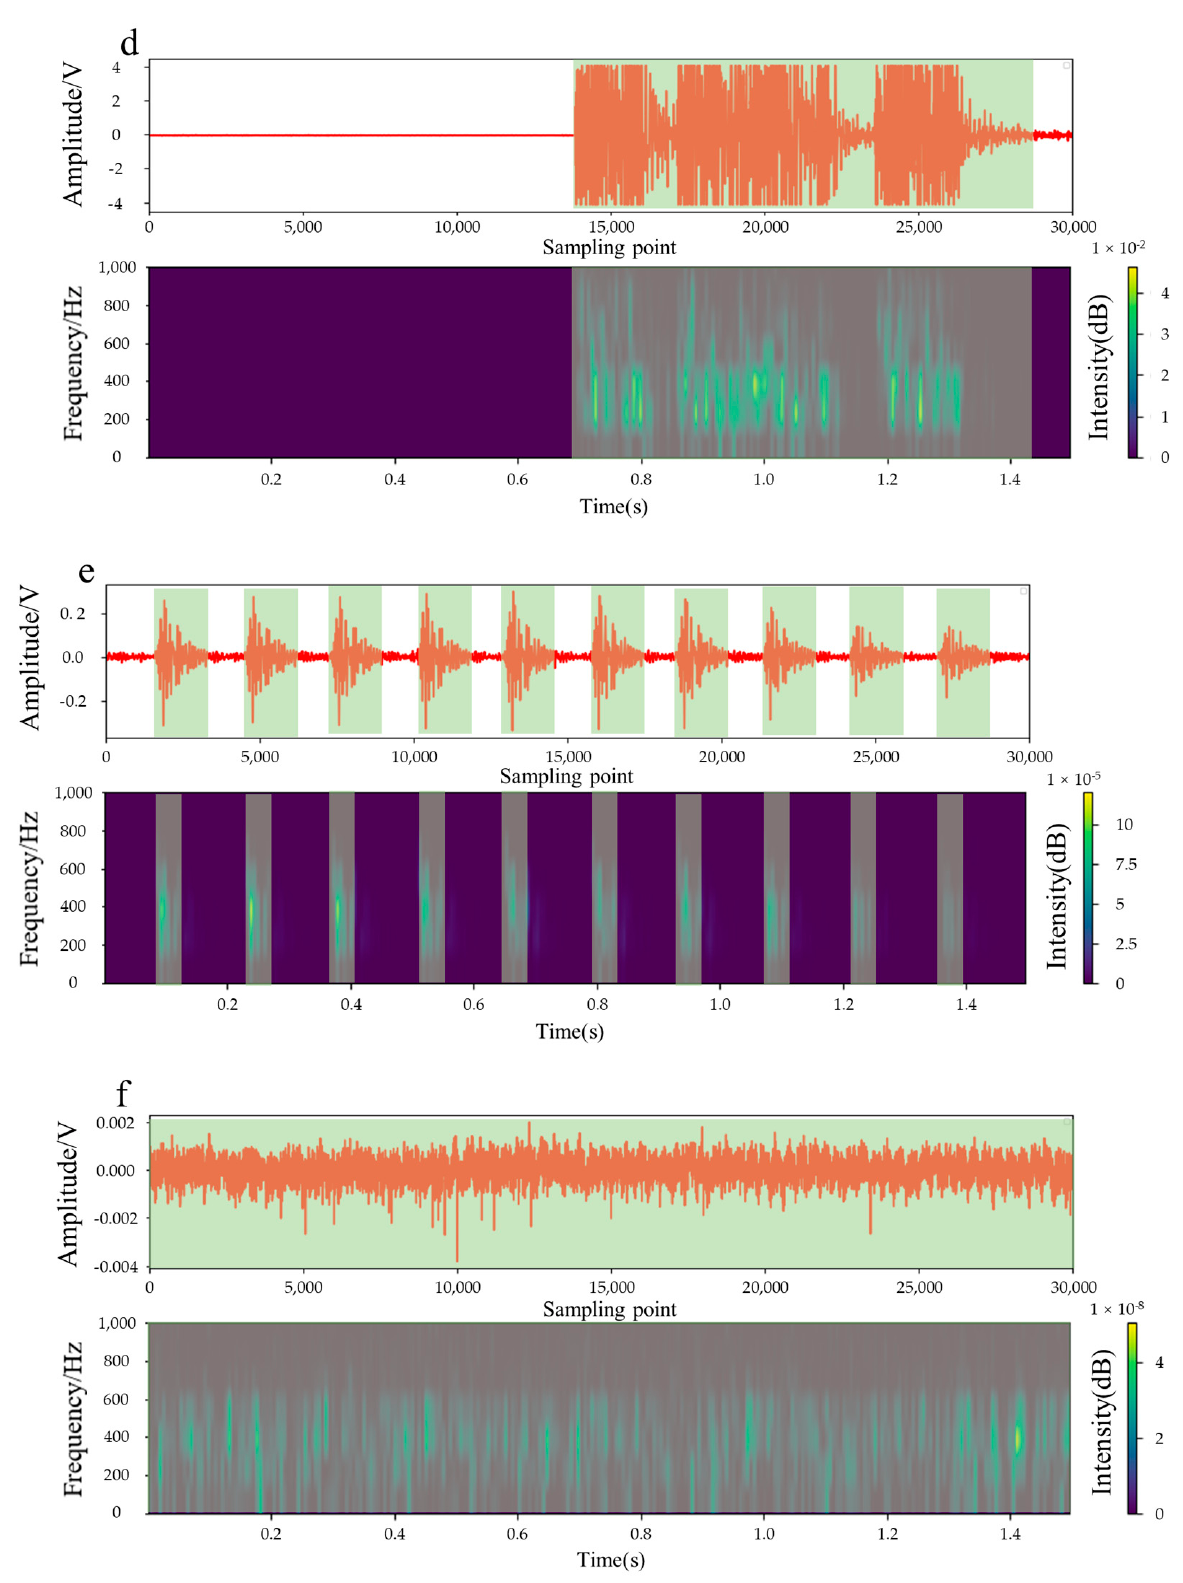
Figure 1. Various common signals and their amplitude spectra. The light green area represents the main time domain or frequency domain characteristics of the signal: ( a , b ) denote the microfracture signals at high and low amplitudes, respectively. ( c ) is the unique noise signal that is similar to the microfracture signal in ( b ); ( d – f ) represent the blast, mechanical, and unknown waveforms, respectively.